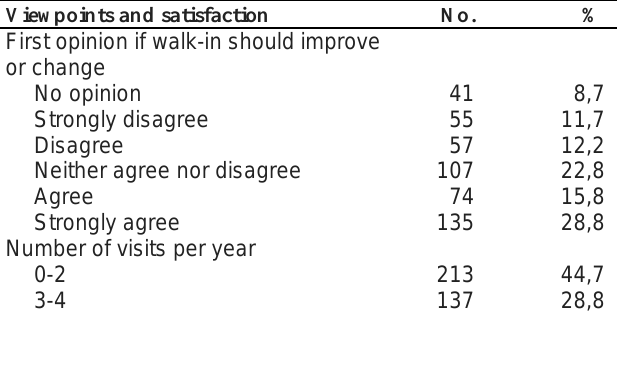
Table 2. MC Viewpoint and satisfaction of the current walk-in